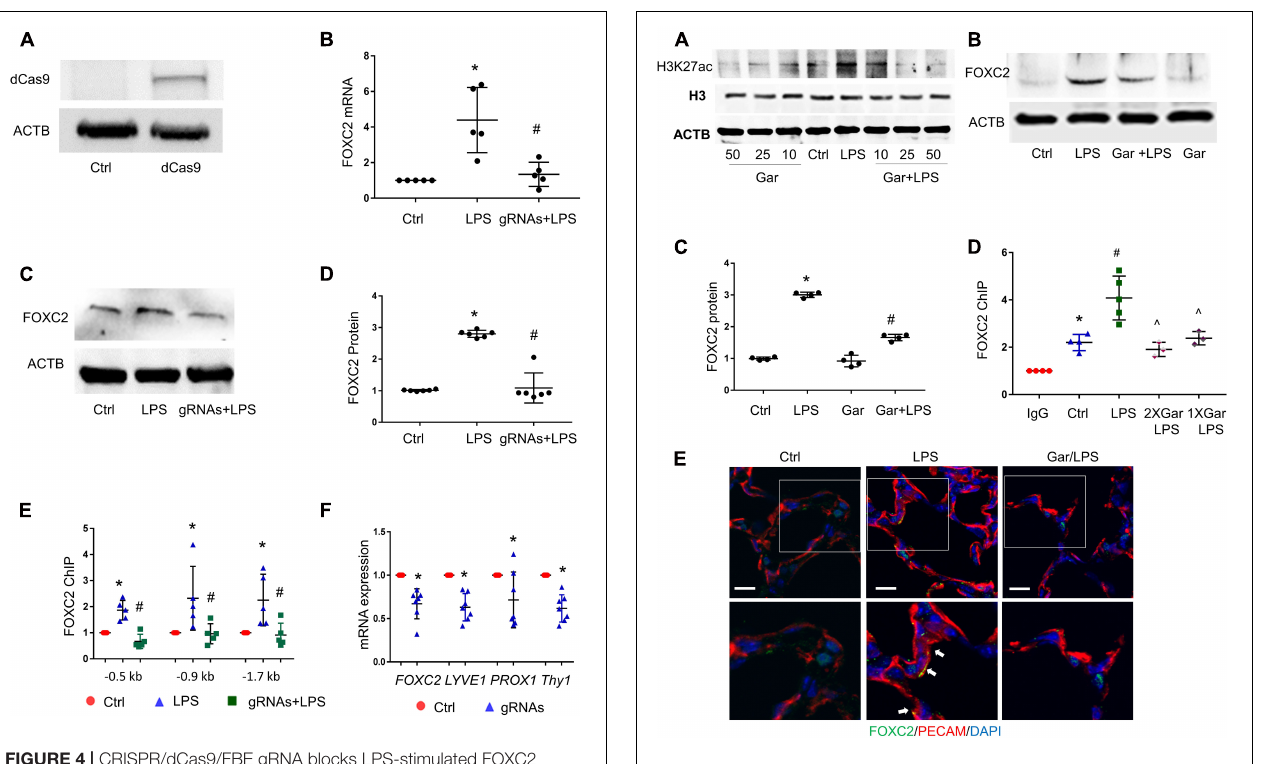
and − 632 separately, which are not predicted by JASPAR.